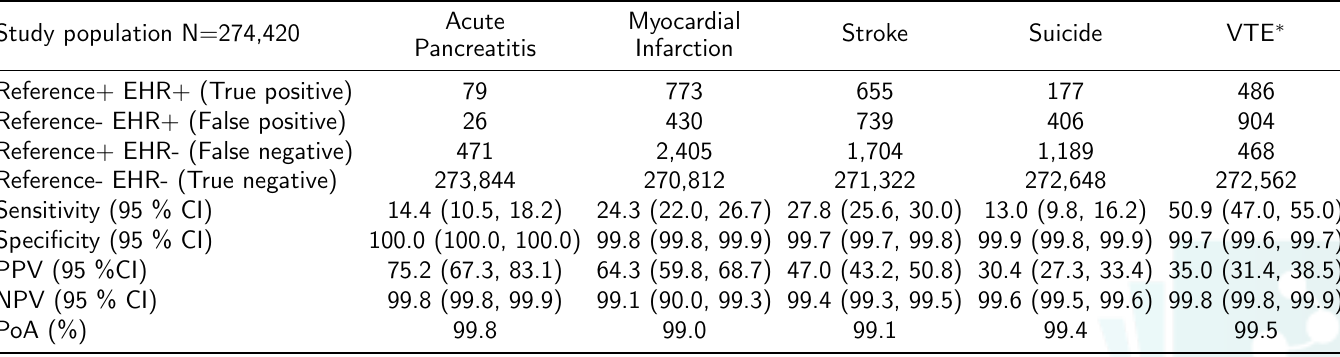
Table 2: Measures of agreement for each acute serious outcome between the EHR (MedicineInsight) algorithms and linked (Reference)